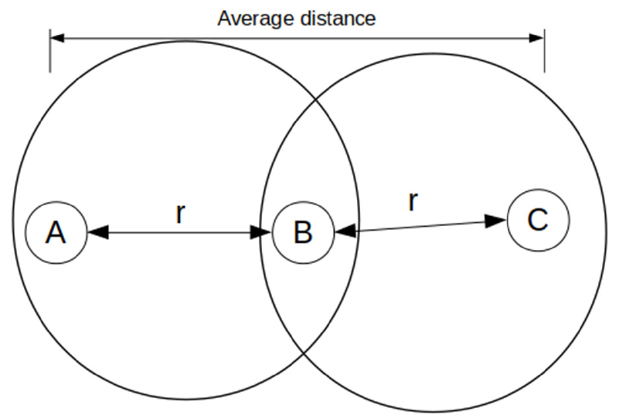
Figure 7. Number of hops representing the expected distance between any two nodes.